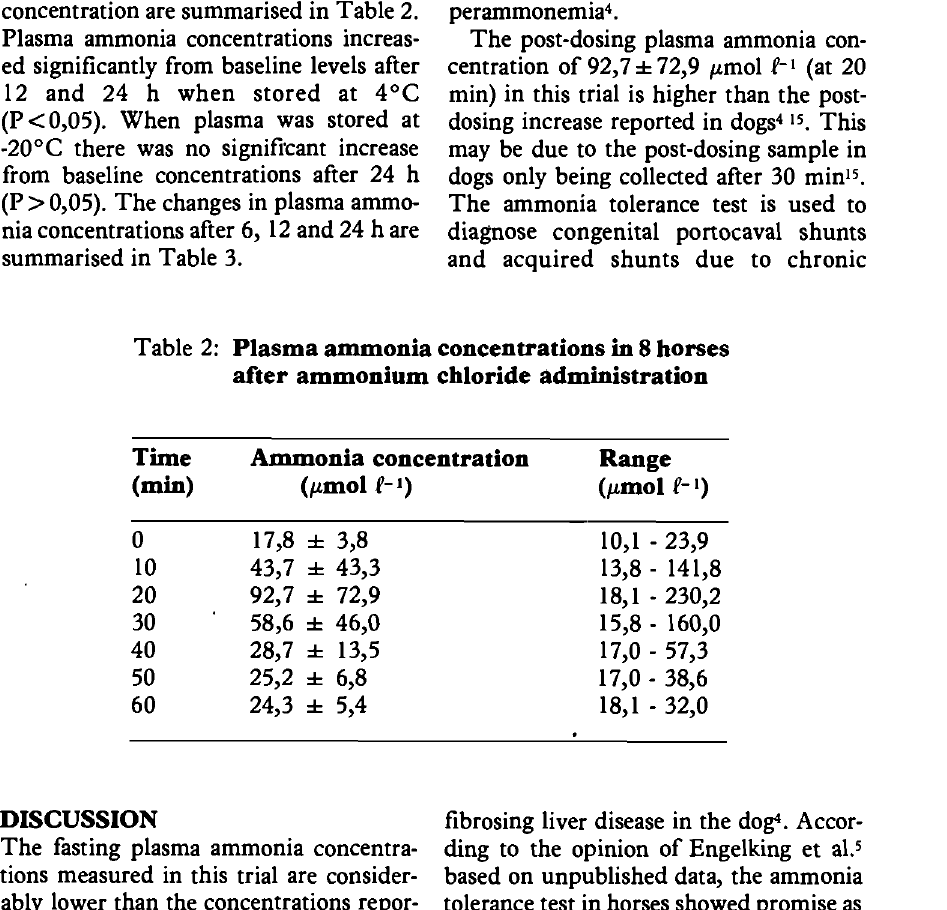
Table 3: Changes in plasma ammonia concentrations (mean ± SD)